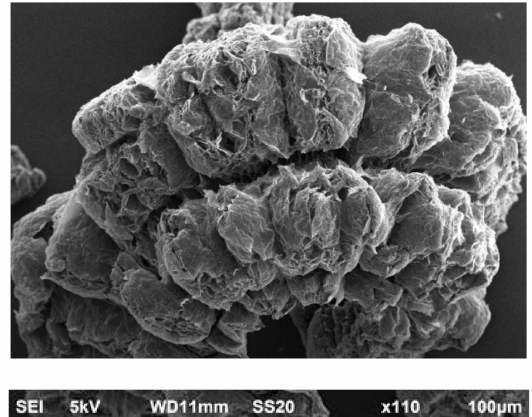
Figure 16. Scanning electron microscope images of expanded graphite, reproduced with permission from Graphit Kropfmuehl GmbH,